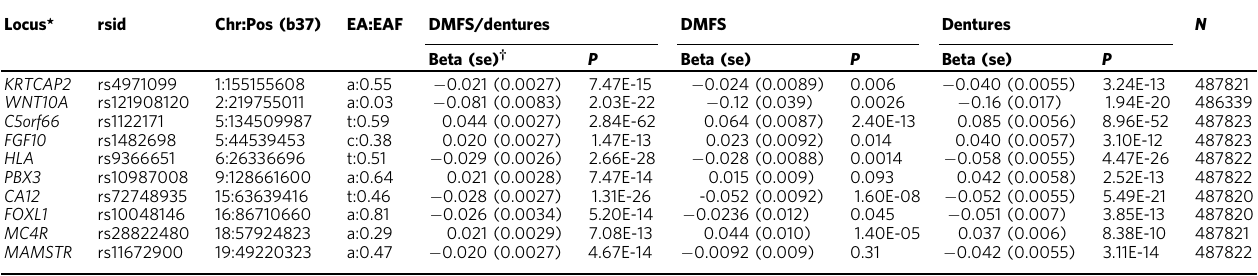
Table 2 Ten lead novel independent loci in DMFS/dentures combined analysis